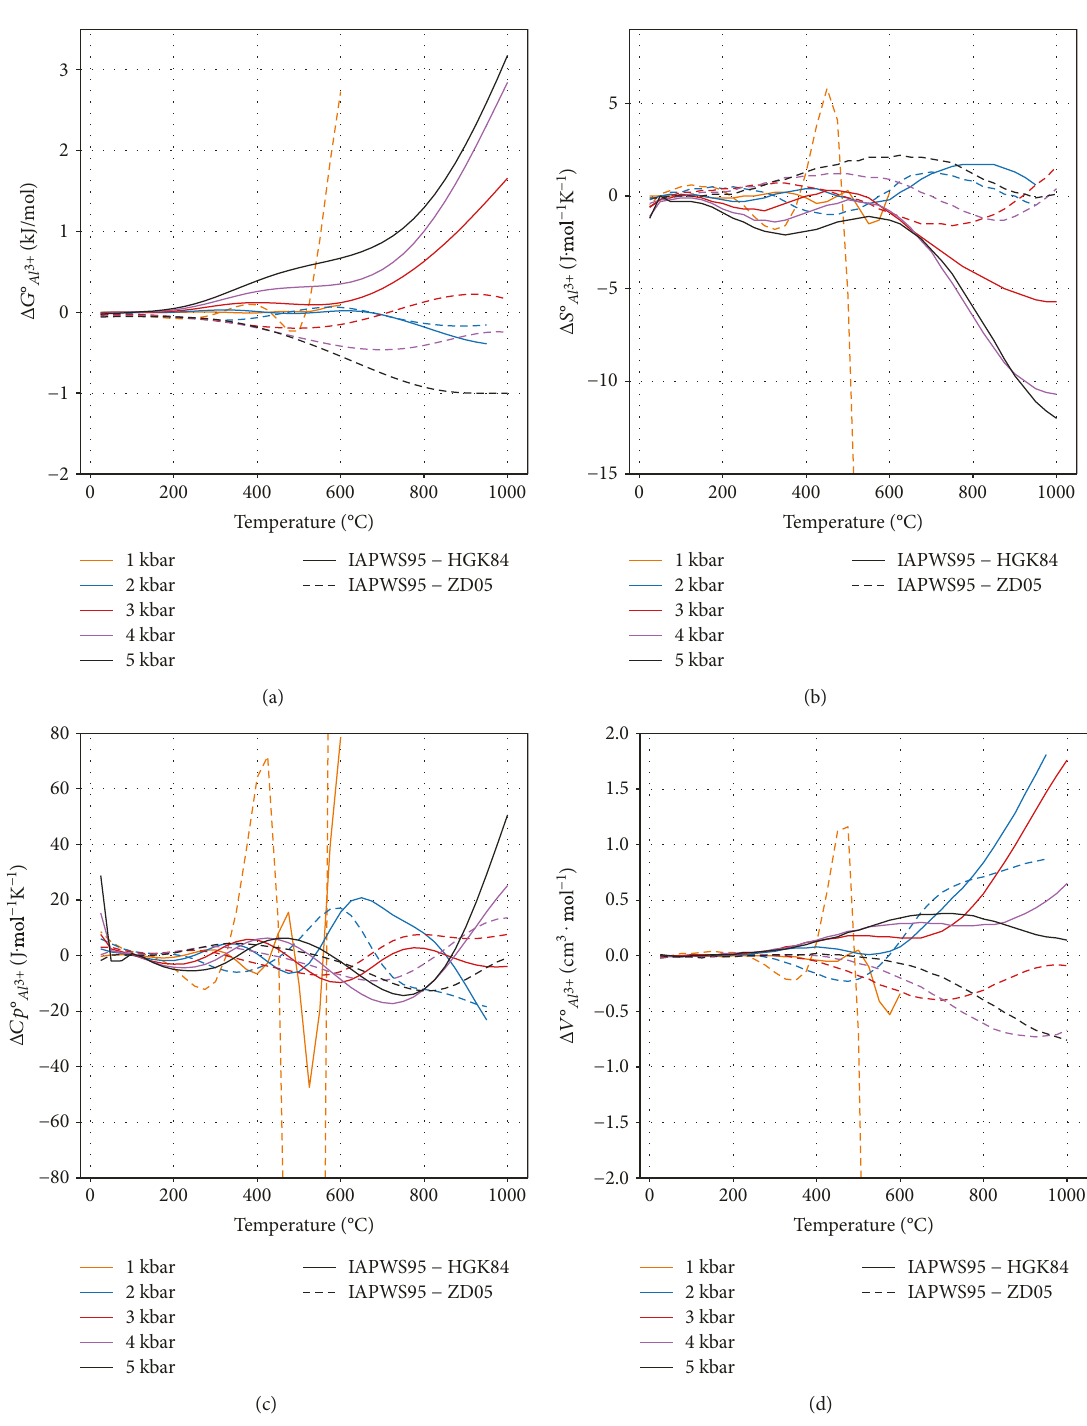
Figure 4: Di ff erences in partial molal standard state properties of Al 3+ , calculated using di ff erent thermodynamic models: full line — di ff erence between IAPWS95 and HGK84, and dashed line — between IAPWS95 and ZD05, all using the FE97 formulation for the water electrostatic properties: (a) G ∘ , (b) S ∘ , (c) Cp ∘ , and (d) V ∘ Al 3+ Al 3+ Al 3+ Al 3+